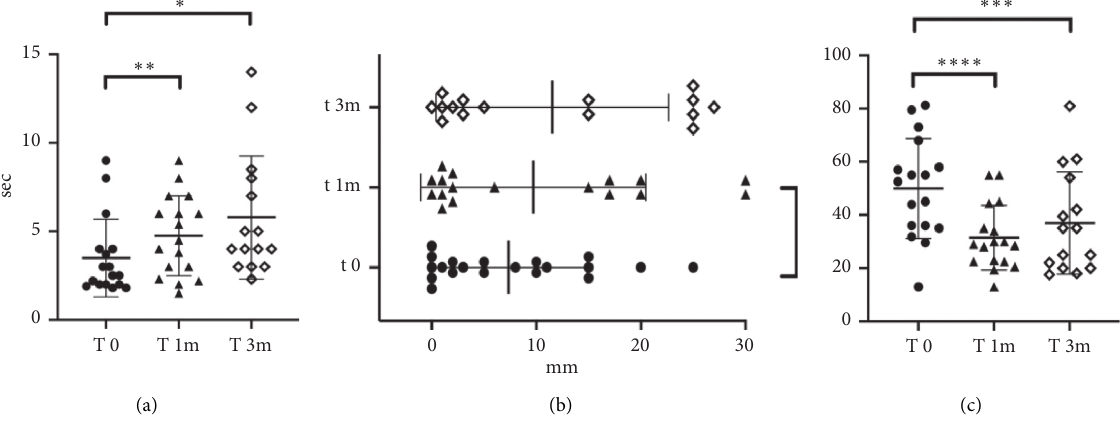
Figure 2: Representative values at different time points. (a) BUT values. (b) Schirmer test values. (c) OSDI values. Table 2: Variables under consideration at different time points. Measure T0 T1 T3 BUT (sec) 3.5 ± 1.65 5.3 ± 2.7 8.6 ± 7.9 50.5 ± 17.5 38.31 ±